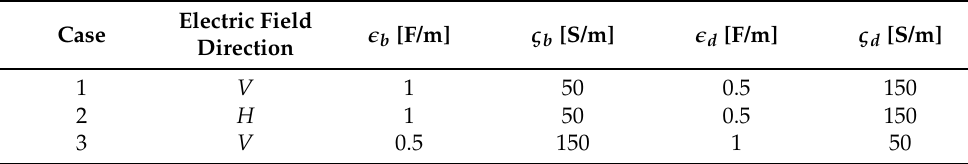
Table 5. Simulation parameters of the coupled EHD-TC cases where vertical ( V ) and horizontal ( H ) electric fields are